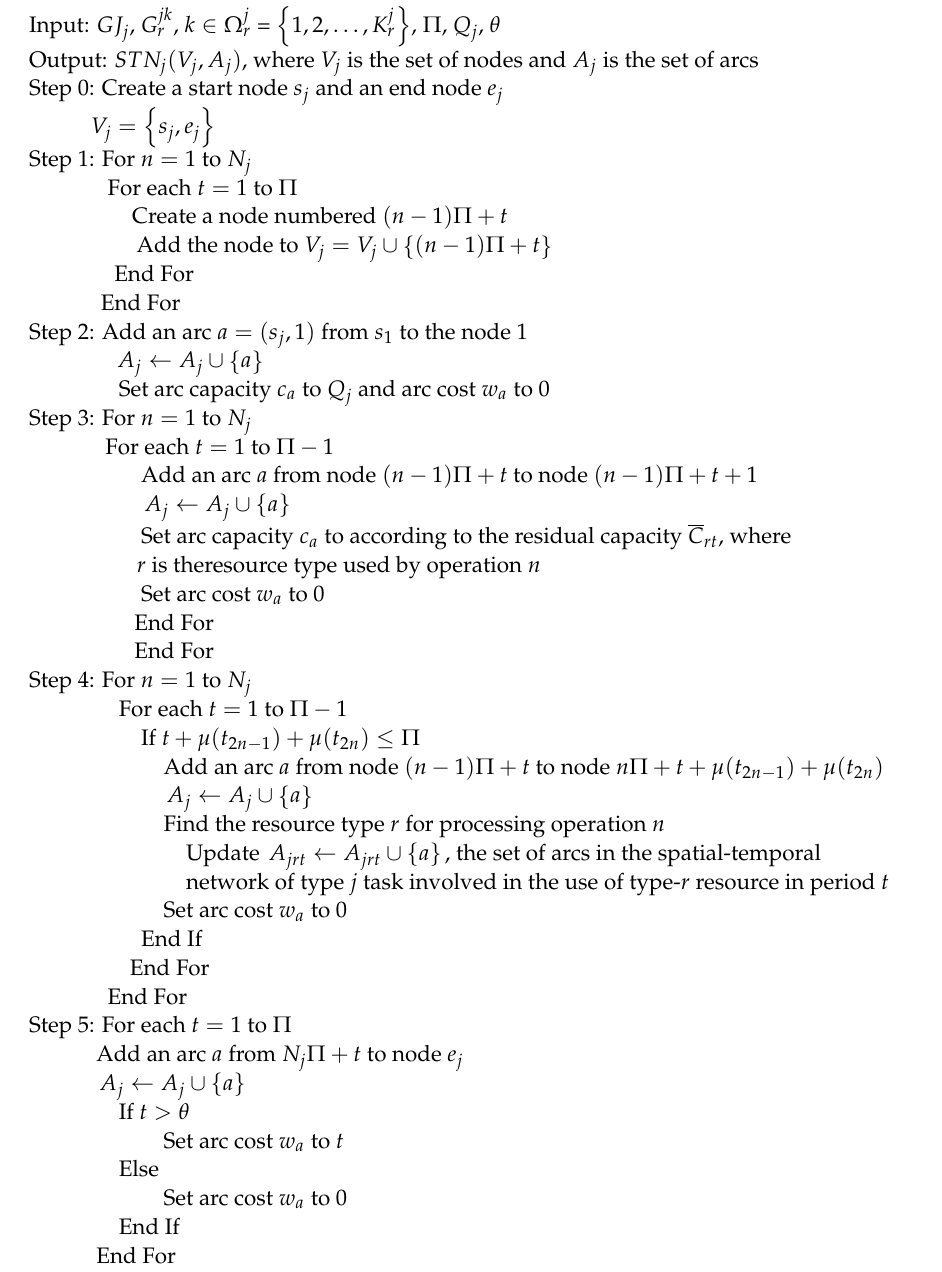
(Algorithm 1) to construct STN j ( V j , A j ) for type j tasks, where j ∈ J , is as follows. Algorithm 1: Construct Spatial-Temporal Network STN j ( V j , A j ) for Type j